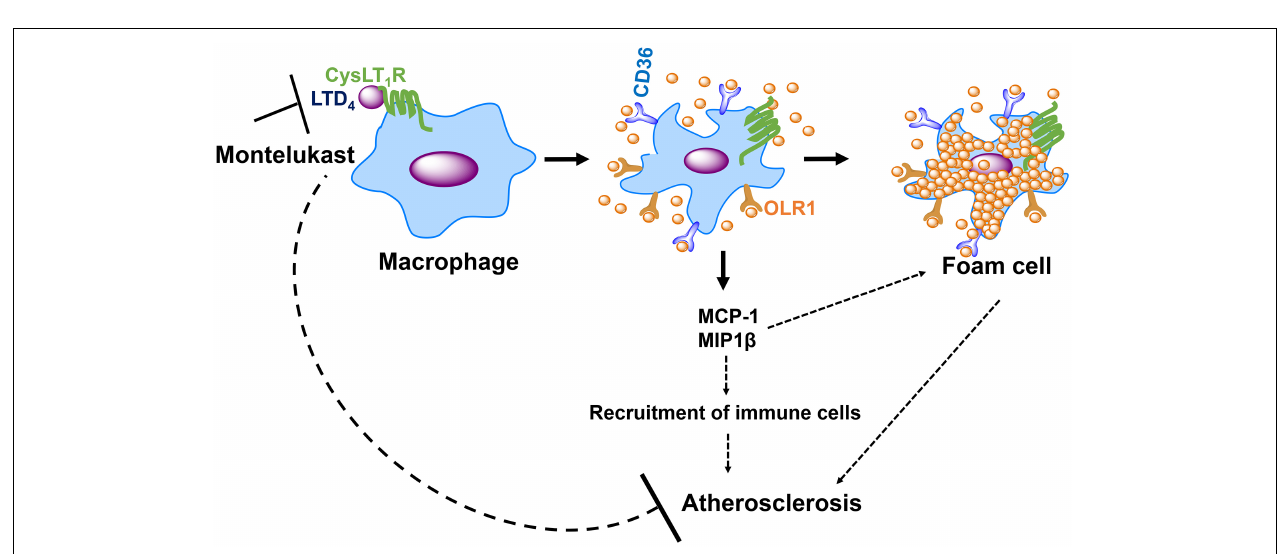
FIGURE 7 | Schematic, suggests the role for CysLT 1 R in macrophage activation and atherosclerosis. LTD 4 stimulation induces the upregulation of oxLDL receptors, OLR1, and CD36 via CysLT 1 R, which in turn facilitates oxLDL uptake in macrophages, resulting in foam cell formation. LTD 4 also induces the secretion of MCP-1 and MIP1 β in macrophages, which further recruits immune cells, amplifying inflammation. These events can lead to atherosclerosis, and our study suggests that CysLT 1 R antagonist, MK (Montelukast) can be used as a novel therapeutic target for the treatment of